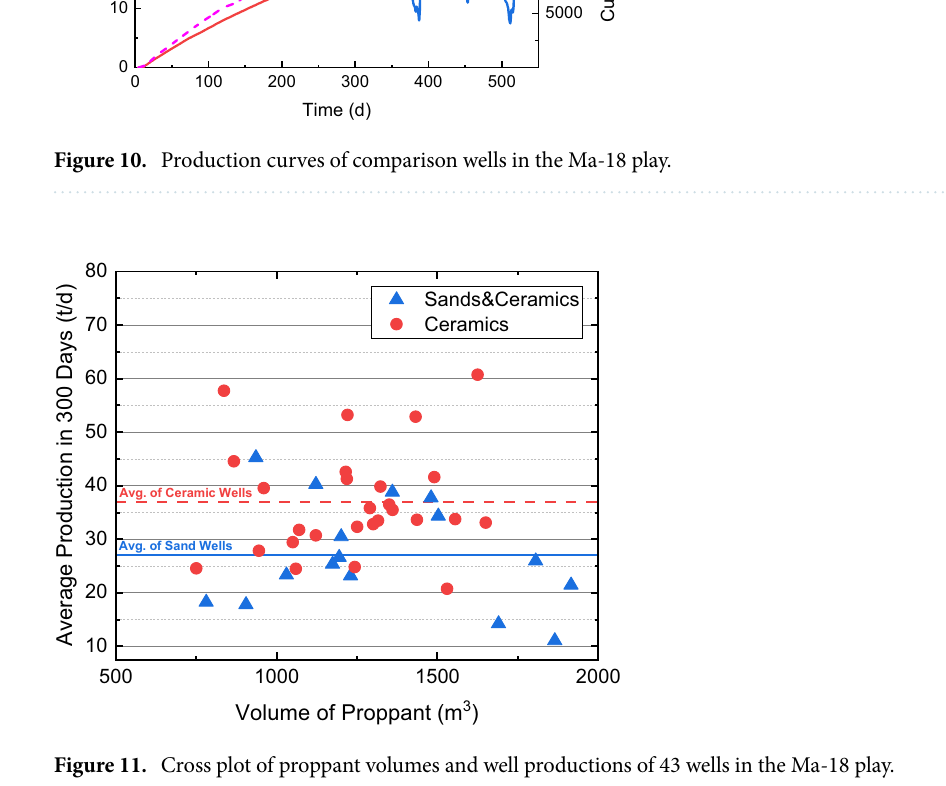
Figure 11. Cross plot of proppant volumes and well productions of 43 wells in the Ma-18